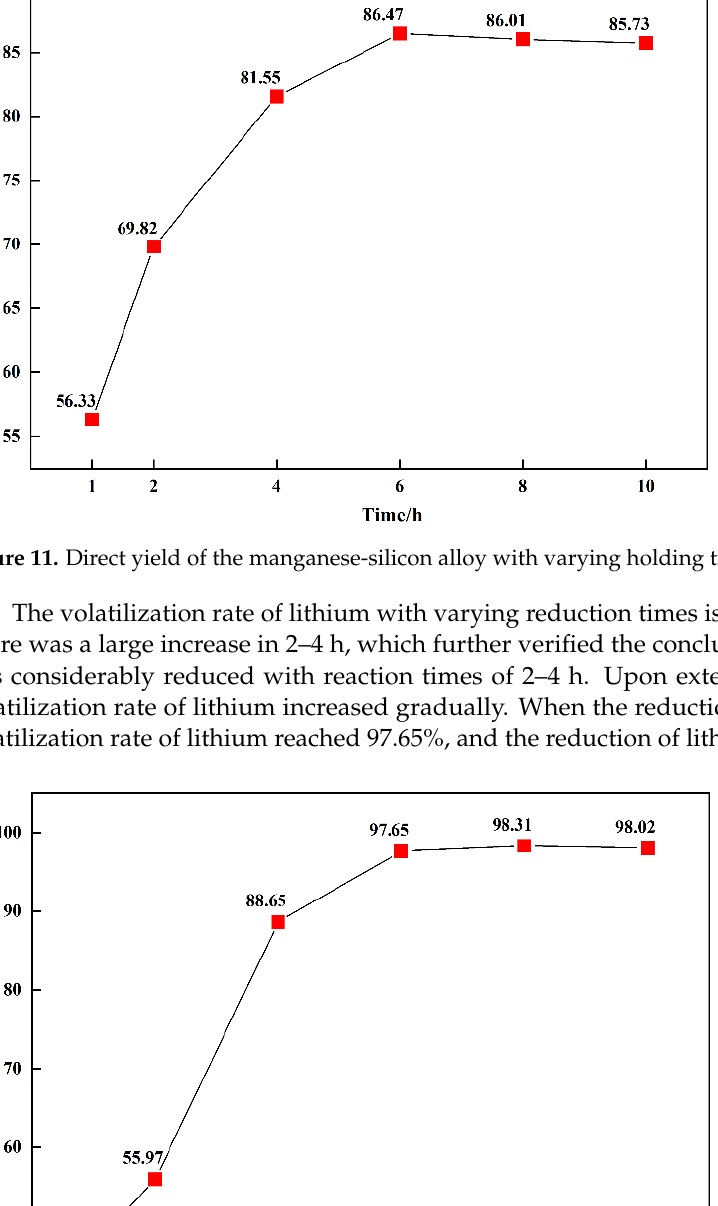
Figure 12. Reduction rates of lithium with varying reduction times.